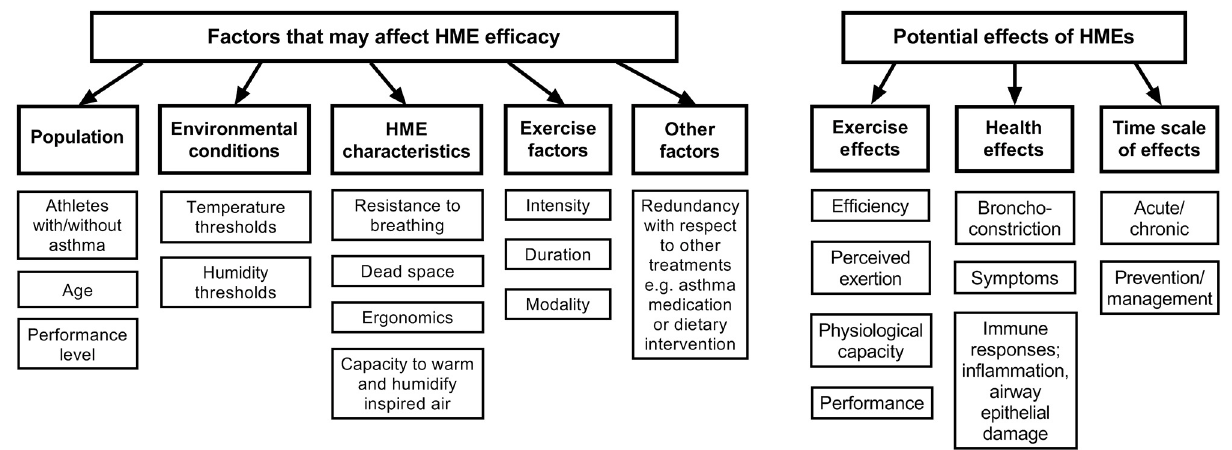
Frontiers in Sports and Active Living |